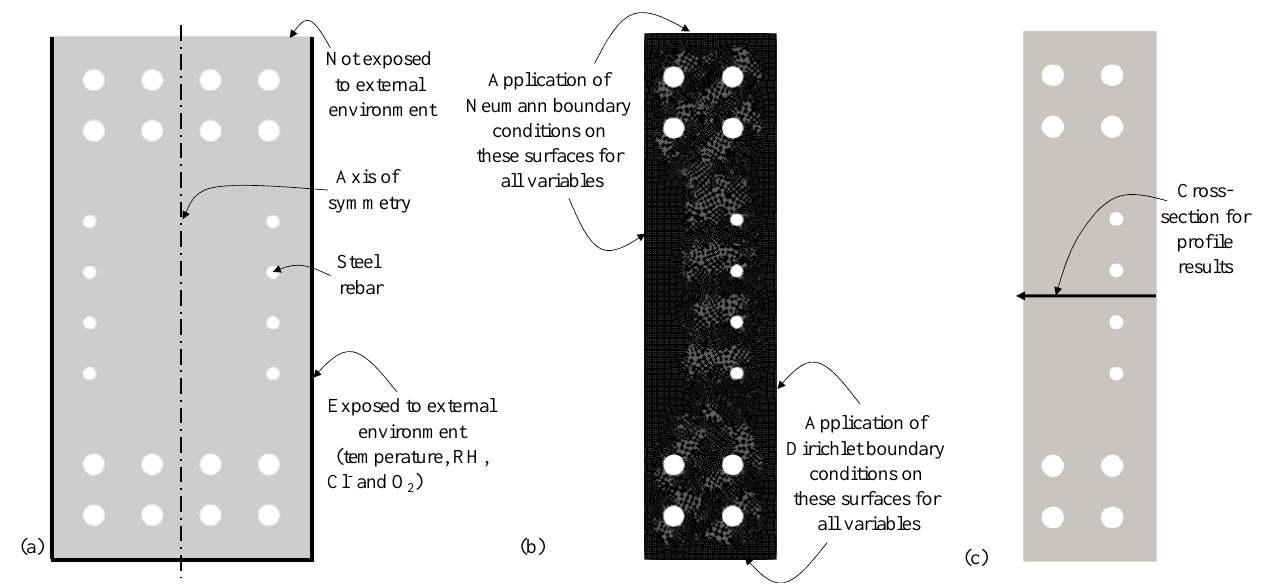
Figure 11. ( a ) Model of the cross-section of the beam, ( b ) meshed geometry, and ( c ) cross-section along which the comparison of results is performed in the concrete domain.